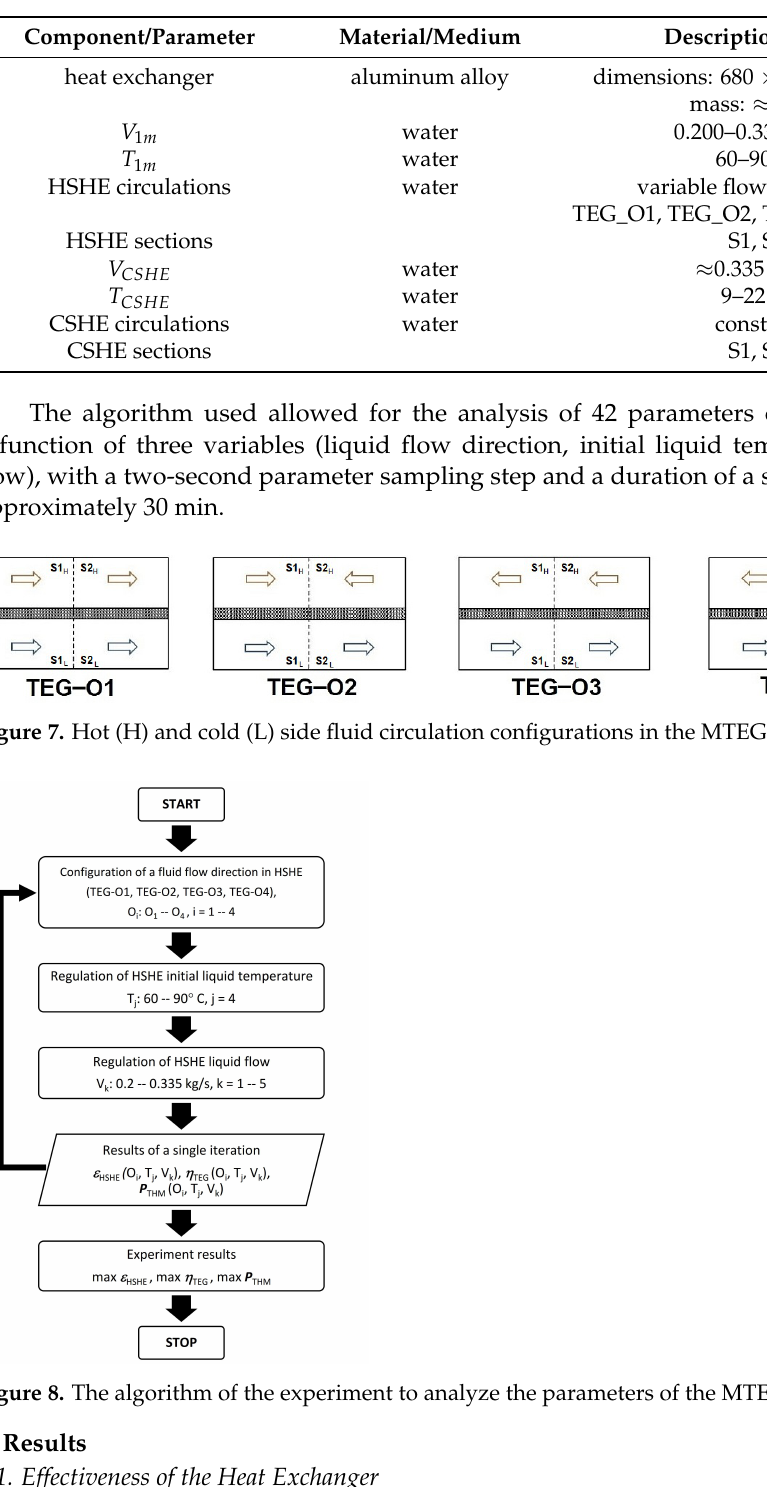
Table 2. Selected parameters of the components of the tested system.